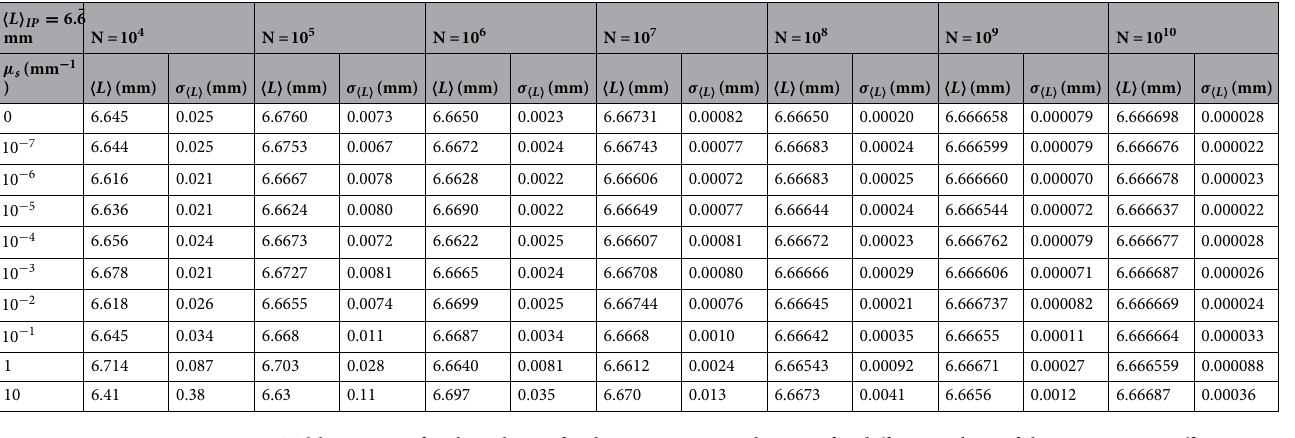
Table 1. Data for the sphere of radius r